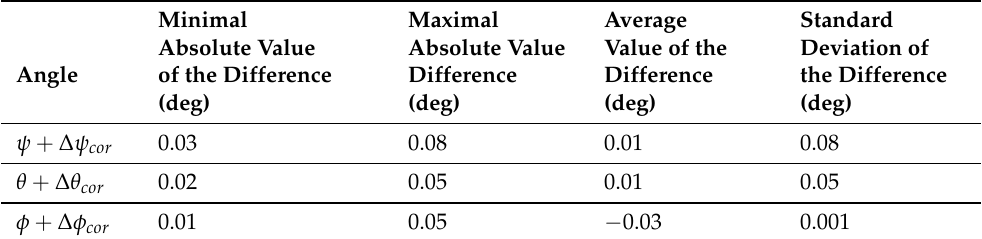
Table 3. Values of statistical parameters characterizing the accuracy of determining angles ( ψ + ∆ ψ ∆ θ ∆ φ cor , θ + cor , phi + cor ) with respect to the angles ( ψ r , θ r , φ r ) for photographs 1–4.